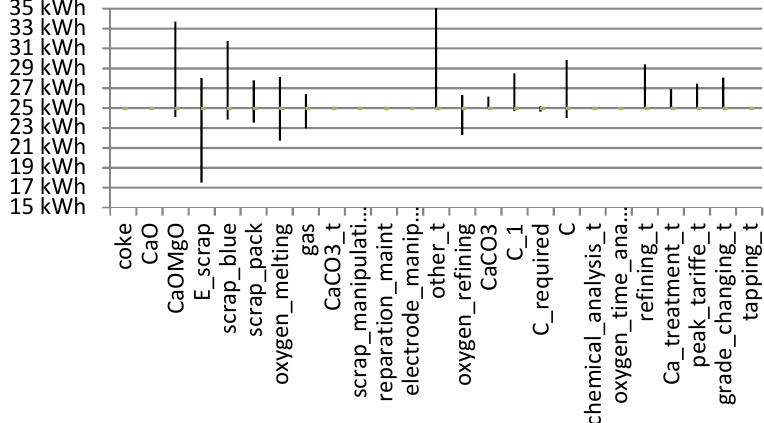
Figure 5. The calculated influences of the individual parameters on the electric energy consumption using a linear genetically developed model.